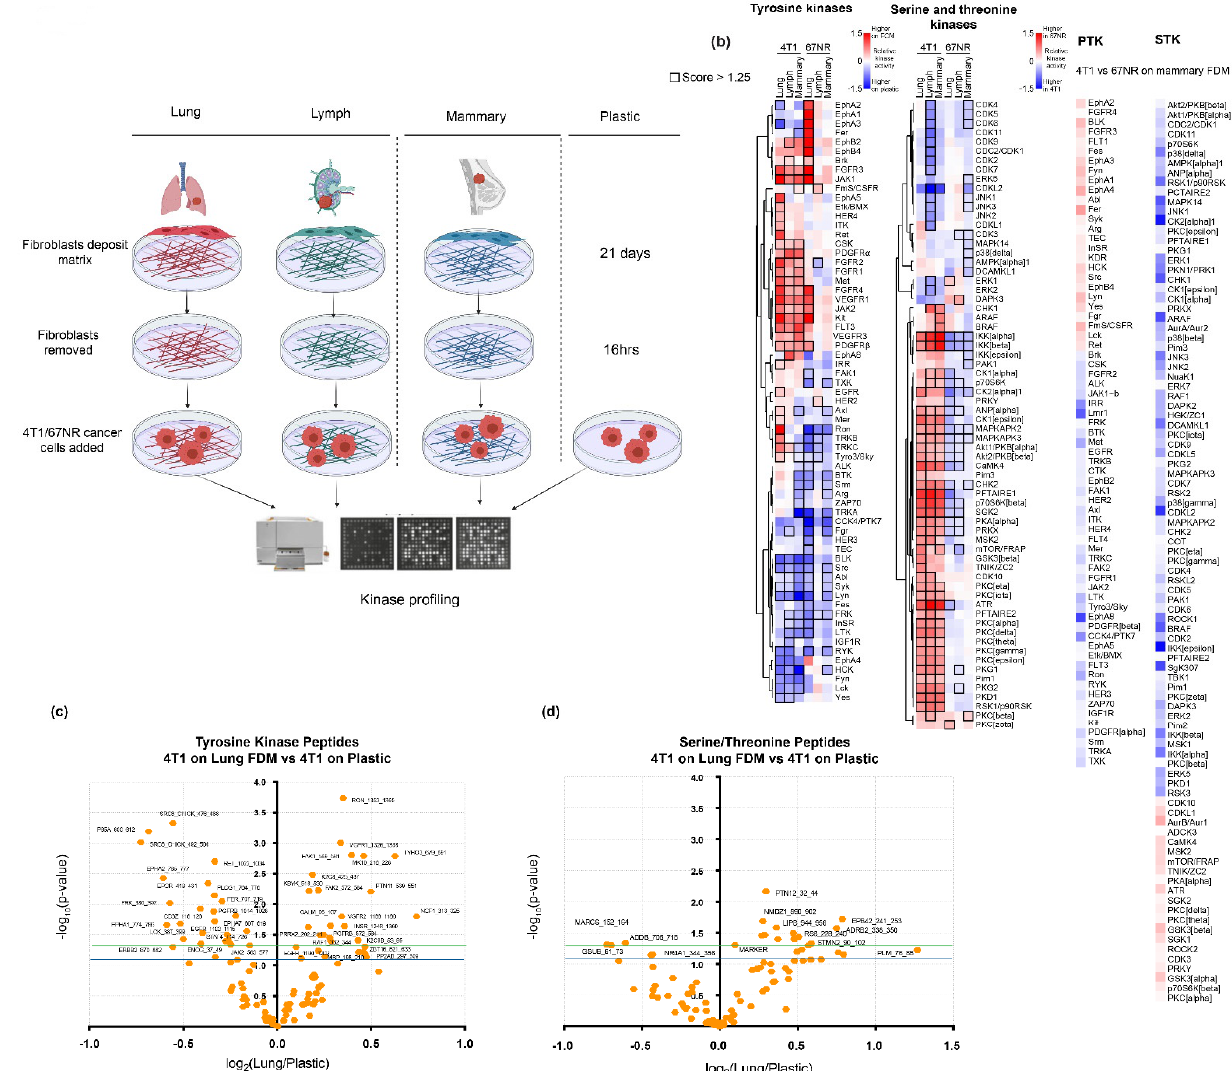
Figure 2. ( a ) Schematic representation of kinase signalling of 4T1/67NR experimental design where FDM is derived from the lung, lymph, and mammary fibroblasts. Fibroblasts are then denuded, and cancer cells seeded on the FDMs and plastic, after which lysates are collected, and kinase profiling is performed. ( b ) Heatmaps comparing Mean Kinase Statistic (relative kinase activity) across the following conditions, 4T1/67NR lung vs. plastic, lymph vs. plastic, and mammary vs. plastic for both tyrosine kinases and serine/threonine kinases (red = higher on FDM). Kinases are clustered hierarchically. Kinase values with a score above 1.25 are enclosed in a black border, representing changes in kinase activity that has reached a reliable threshold. Additionally, kinase activity of 4T1s vs. 67NR on mammary FDM where red kinases show those activated in 67NRs. ( c , d ) Volcano plots show the levels of phosphopeptides detected in 4T1 cells between lung and plastic. Peptides that reached statistical significance ( p -value > –log 10 1.3) are indicated by the green